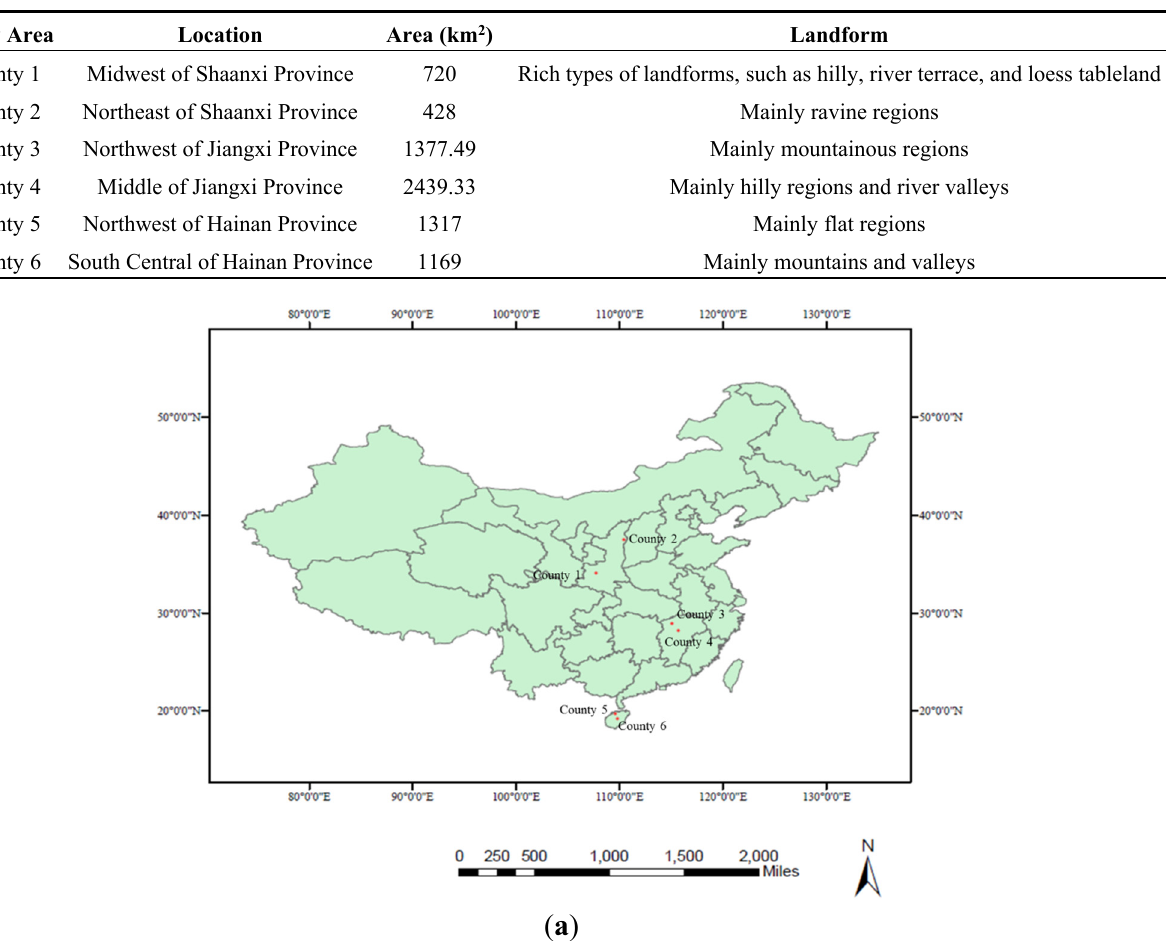
Table 1. Information of the six study